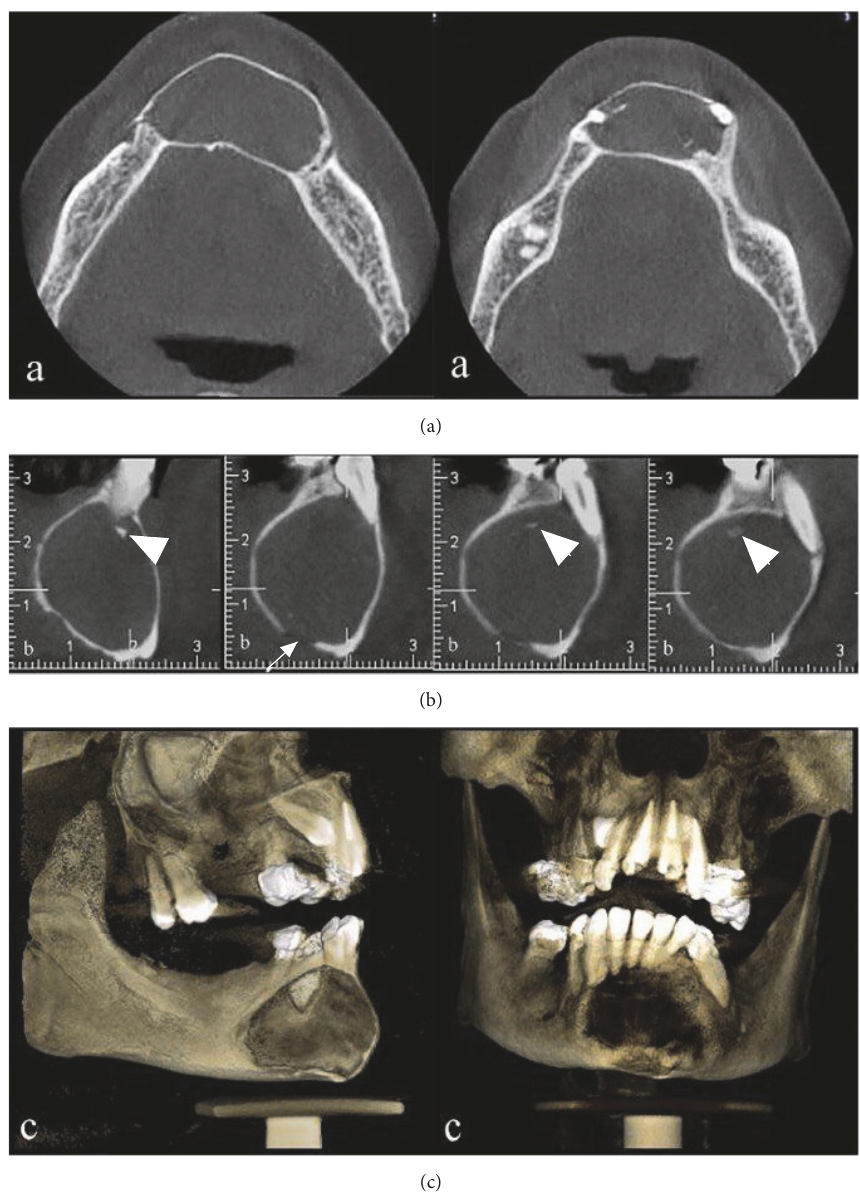
Figure 2: (a) Axial sections show that mental foramen is not involved but has close contact with border of the lesion at the left side. (b) Cross- sectional CBCT images reveal radiopaque spots inside the lesion indicated by white arrows in the image. (c) Three-dimensional volumetric surface